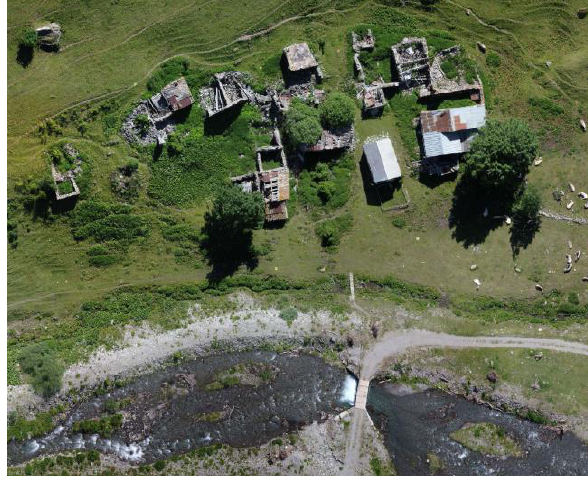
Figure 2. Bout du Col village (Prali – TO).